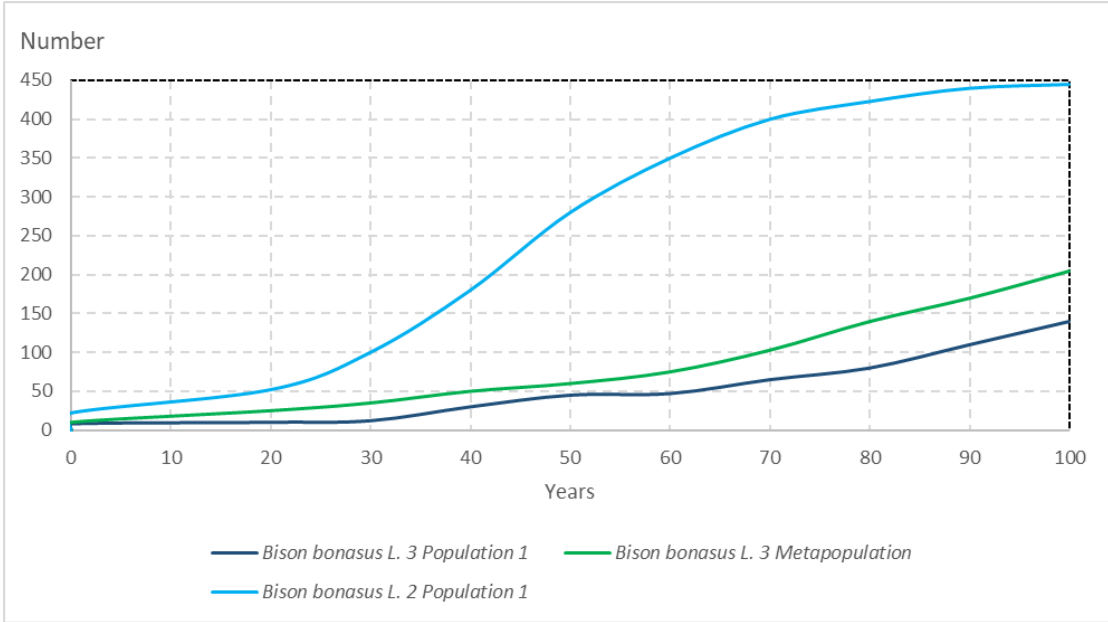
Figure 7. The survival percentage for wisent 2 and wisent 3 scenarios (the initial herd and the cu- mulative one). cumulative